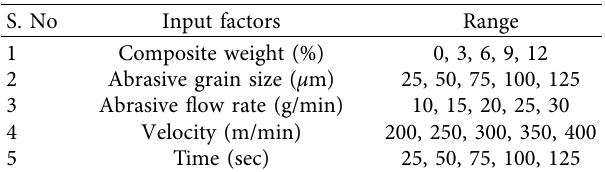
Table 3: Erosion wear test’s input